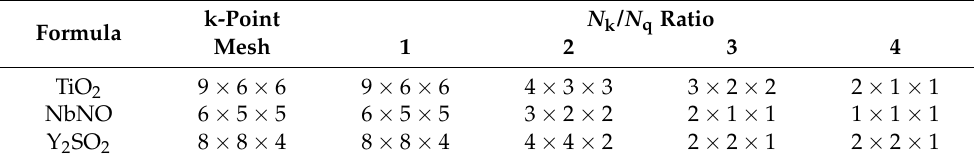
Table A1. Comparison of q -point meshes for each material (TiO 2 , NbNO, Y 2 SO 2 ), corresponding to N k / N q ratios of 1, 2, 3, and 4. For the case where N k / N q =1, the q -point mesh is equivalent to the k -point mesh. k-Point N k / N q Ratio Formula